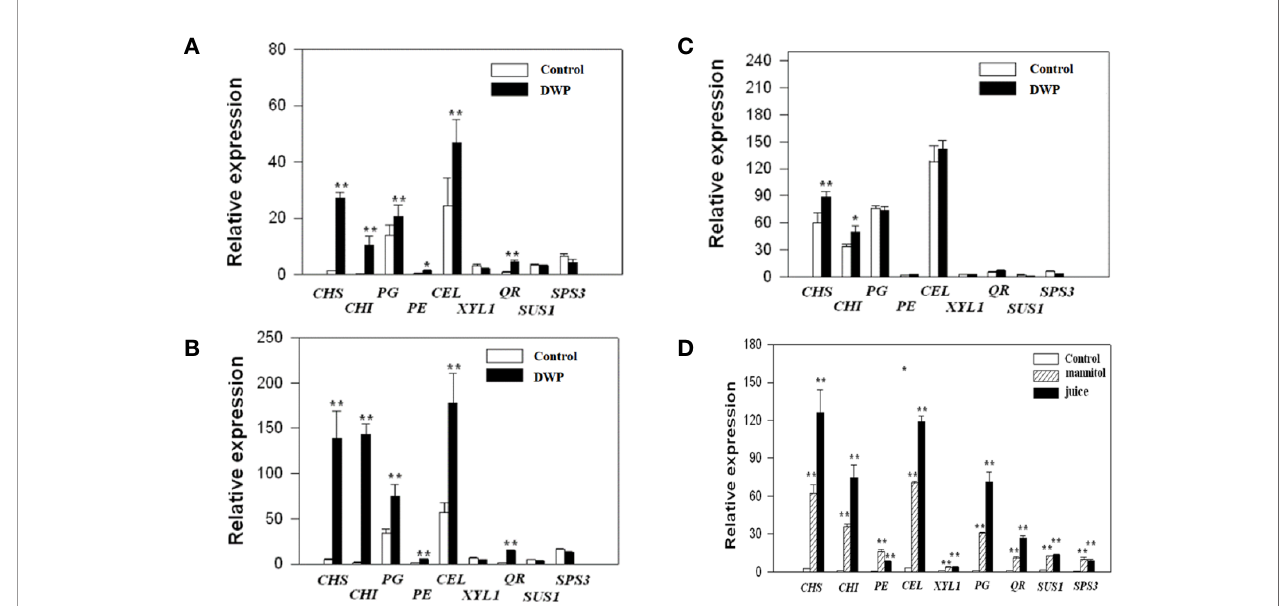
FIGURE 6 | Expression of ripening-related genes in response to decrease in water potential (DWP) or decrease in osmotic potential (DOP) treatments. For DWP treatments, fruit at different developmental stages were allowed to lose water under ambient conditions for 12 h, and when the fruit weight was ~ 85% of the original fresh weight, the fruit were then sampled for gene expressional analysis by quantitative real time (qRT)-PCR. For DOP treatments, receptacles at the large green (LG) stage were cut into slices and incubated for 5 h in 0.65 M mannitol or juice derived from fully ripened fruits (see Materials and Methods for detailed information). Controls were no DWP or DOP treatment. qRT-PCR values were normalized to the expression values of FaACTIN and expressed as the fold changes of the control. (A) Fruit at the middle green (MG) stage. (B) Fruits at the large green (LG) stage. (C) Fruits at the reddening (R) stage. (D) Fruits treated with mannitol and juice at the LG stage. Bars are the mean ± SD of 3 biological replicates. Asterisks denote signi fi cant differences compared with the control at *P < 0.05 and **P < 0.01, according to a Student ’ s t